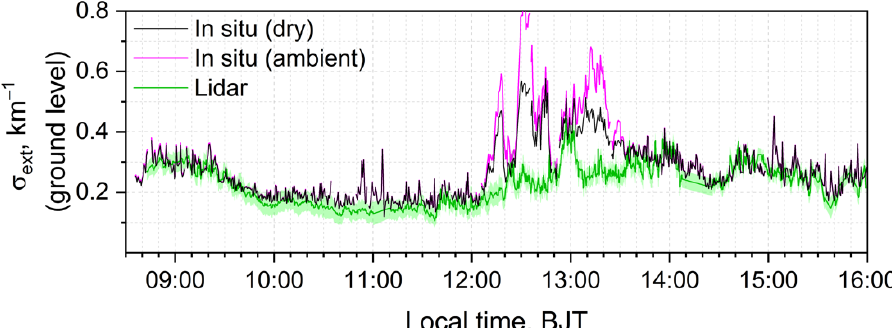
Figure 6. Spatio-temporal variability of aerosol extinction coefficients at 525 nm derived from in situ measurements (nephelometer and aethalometer) with no correction for RH (black) and with f(RH) correction (magenta), and LIDAR-derived extinction coefficients at 532 nm at a 210 m altitude (green). The green shaded area represents the uncertainty on the derived extinction coefficients.